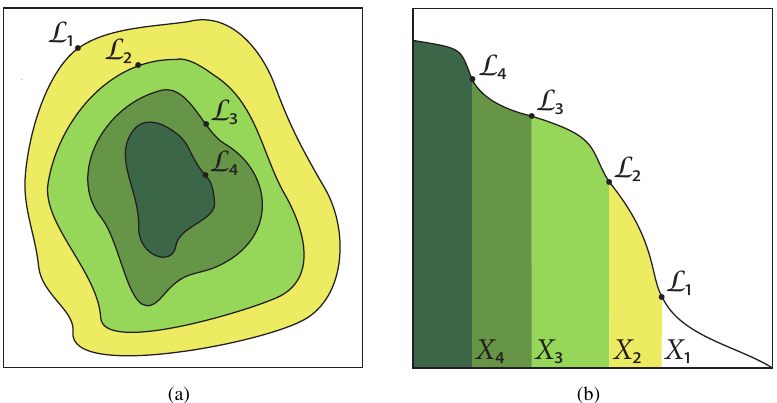
F IG . 1.— Cartoon illustrating (a) the posterior of a two dimensional problem; and (b) the transformed L ( X ) function where the prior volumes, X i , are associated with each likelihood, L i